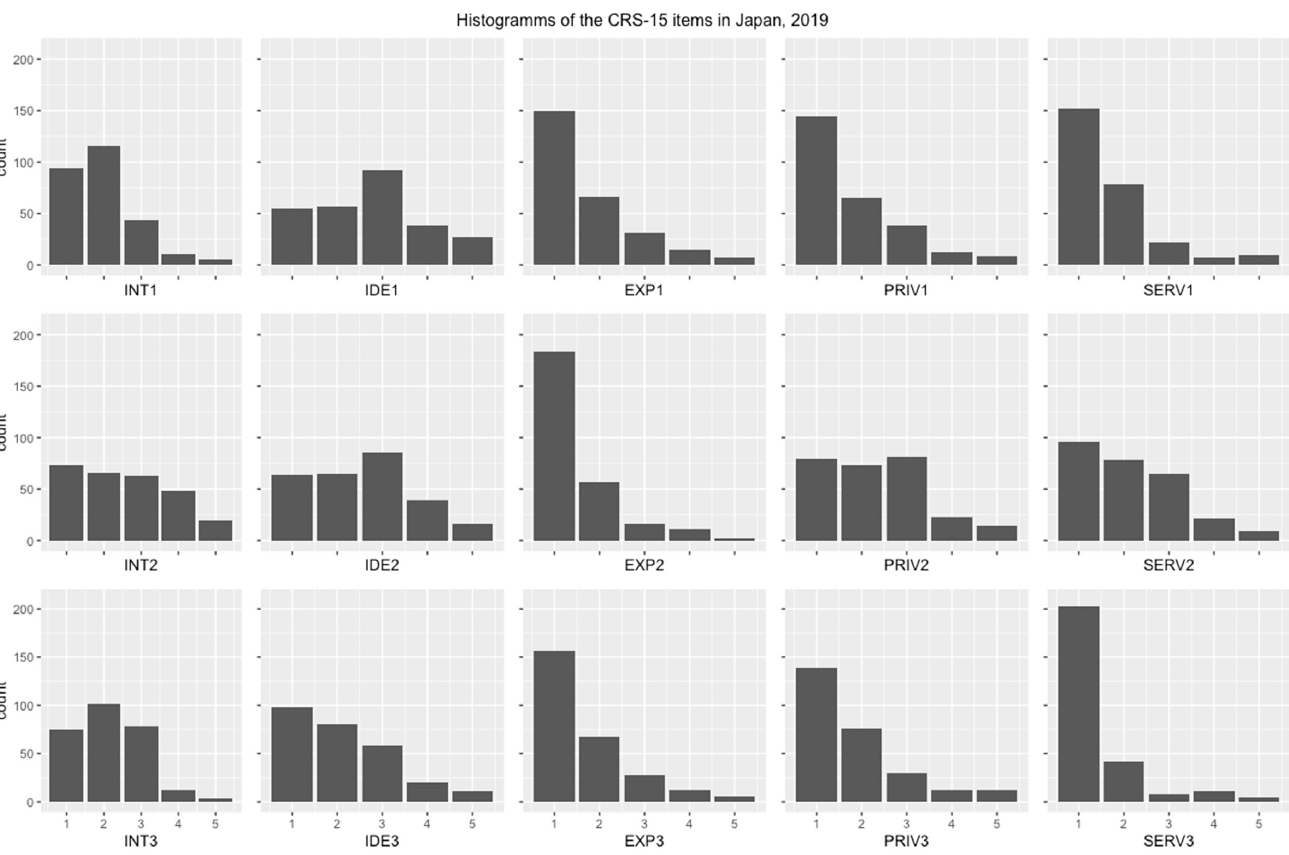
Figure A1. Histograms of CRS-15 items. Int = intellect; ide = ideology; serv = public practice; priv = private practice; exp = experience. The number after the item name indicates the position of the item within the core dimension items. The upper row contains the items of the CRS-5, adding the middle row constitutes the items of the CRS-10, and including the lower row you get all items of the CRS-15.